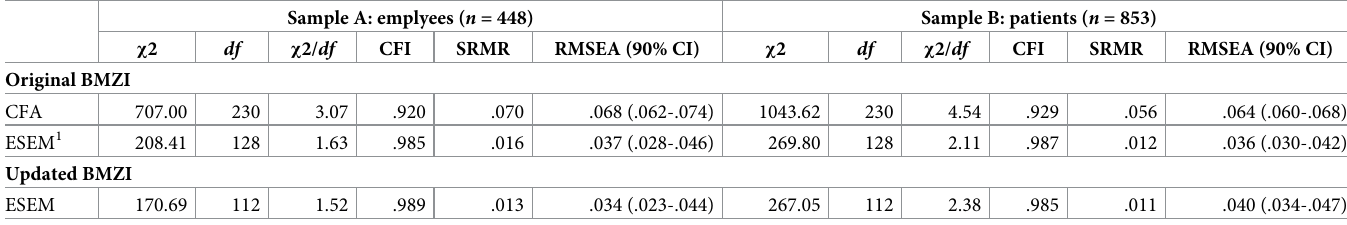
Table 1. Factorial validity of the original and updated version of the BMZI.